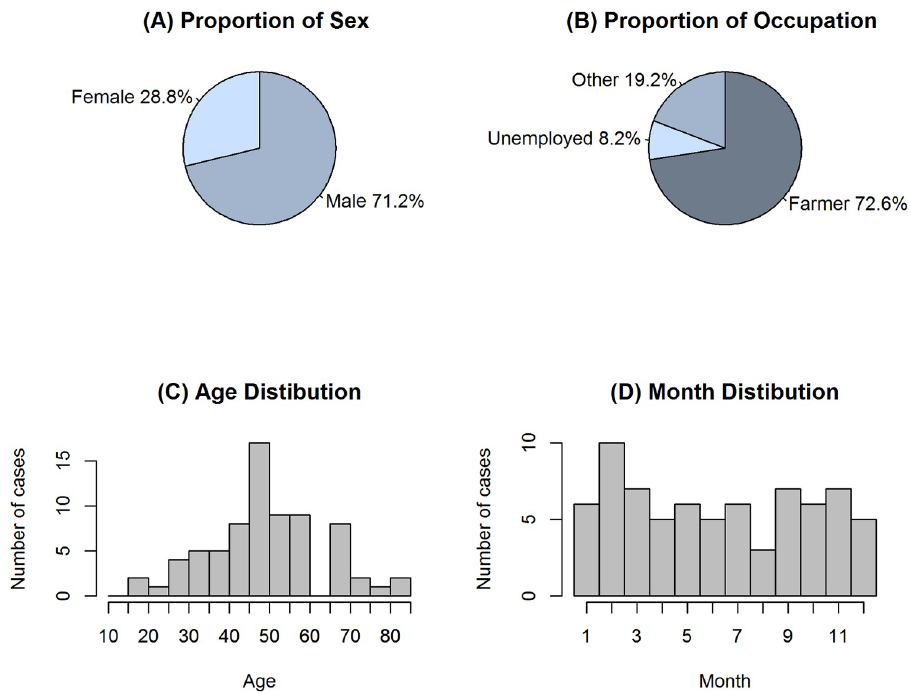
Fig 1. Demographic characteristics of HFRS patients. Characters of 73 laboratory-confirmed HFRS cases. (A) and (B) are pie charts of proportions of sex and occupation, respectively. (C) and (D) are histograms used to show distributions of age and time (month) of disease